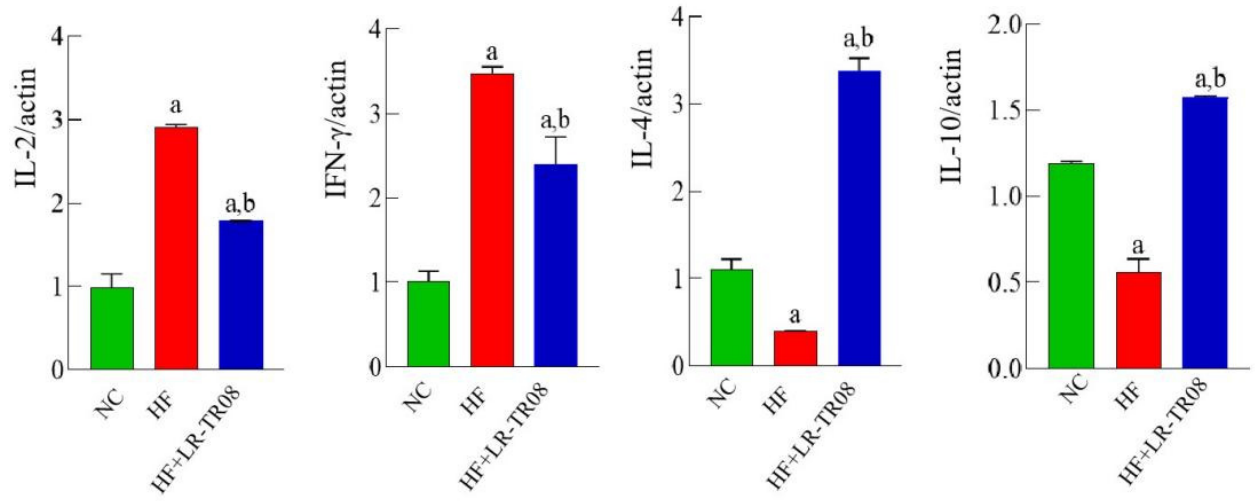
Figure 4. The mRNA expressions of inflammatory factors in mouse spleen. a: compared with the NC group, p < 0.05; b: compared with the HF group, p < 0.05. Normal control group: NC, high − fat diet group: HF, and high − fat diet + L. rhamnosus TR08 strain group: HF+LR − TR08.